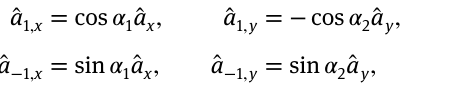
Figure 2: Design principle of four phase gradient supercells for binary-pixel metasurface, denoting as  ,  ,  ′ , and  ′ . (a) The combination of pixel consisting supercell  and pixel consisting supercell  can convert the incident light E the left. The combination of two pixels consisting supercell  ′ or  ′ convert the incident light E the left. (b) The supercell  has opposite linear phase gradient for 𝜙  that of 𝜙  and 𝜙  , while there is phase delay 𝜙  yy xx phase delay between binary-pixel consisting supercell  ′ and  ′ satisfies 𝜙  ′